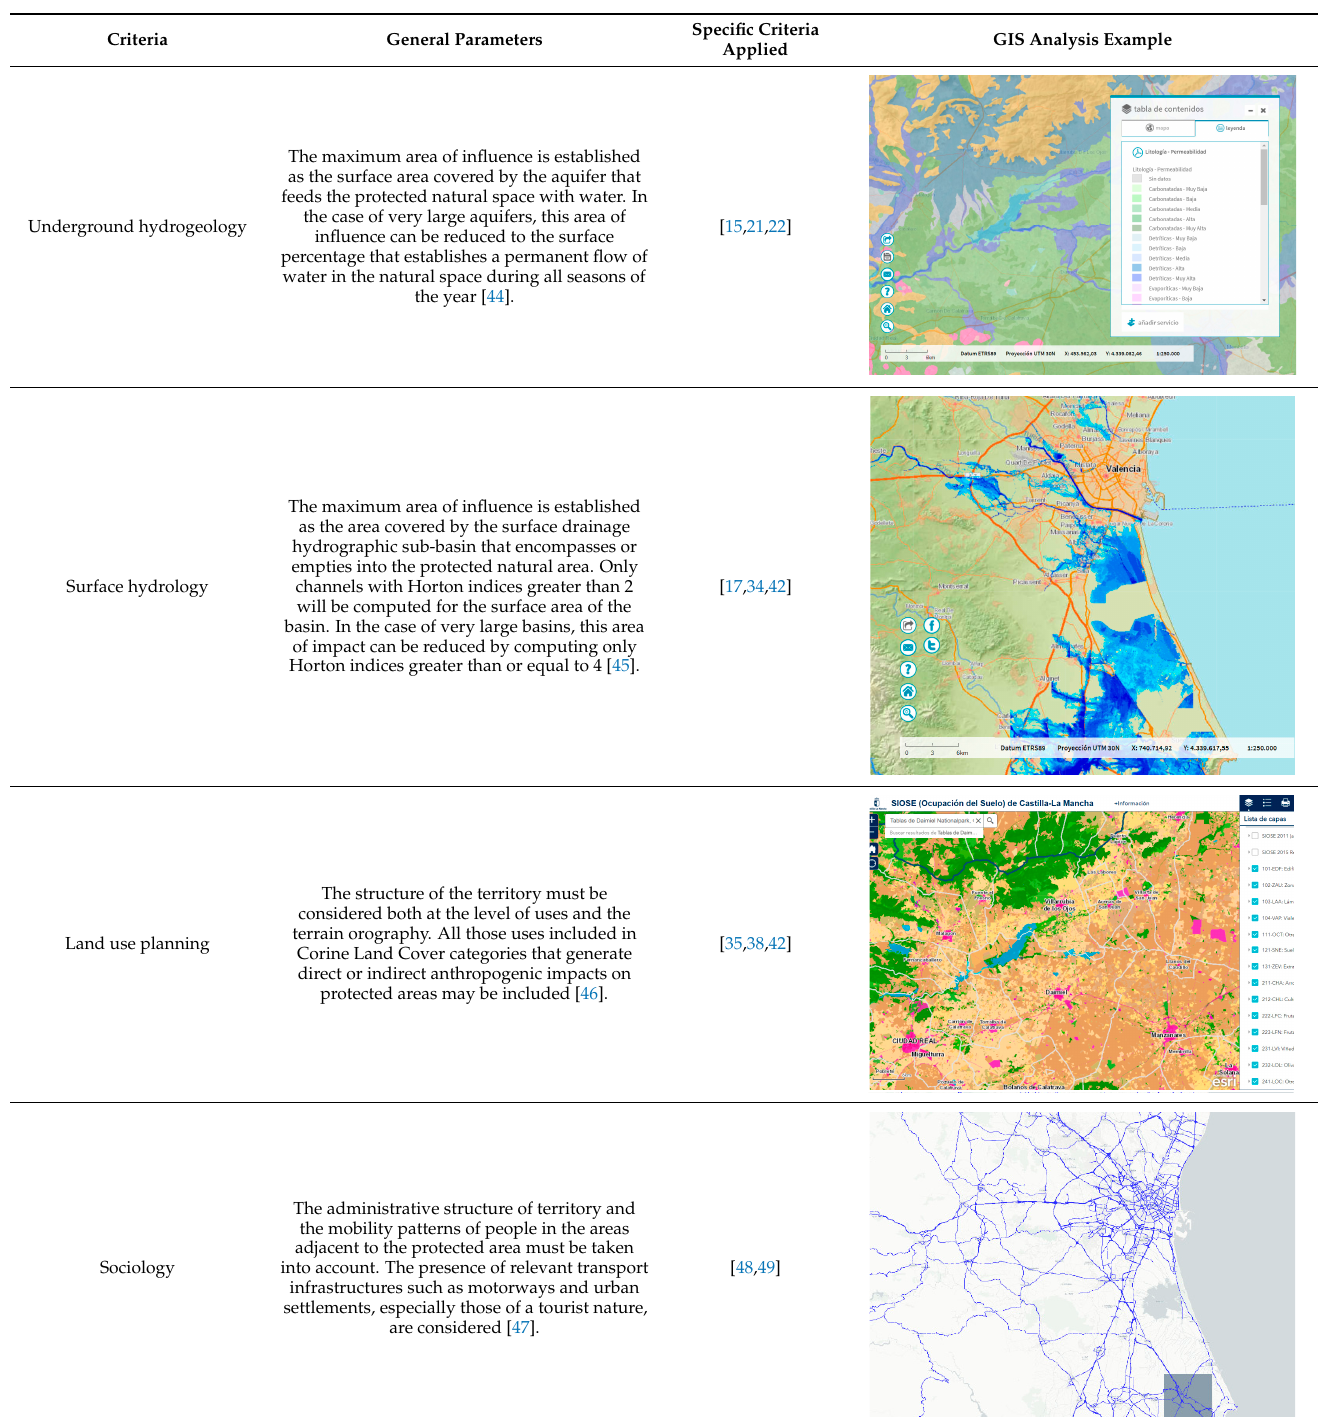
Table 1. General and specific criteria applied for AIDA